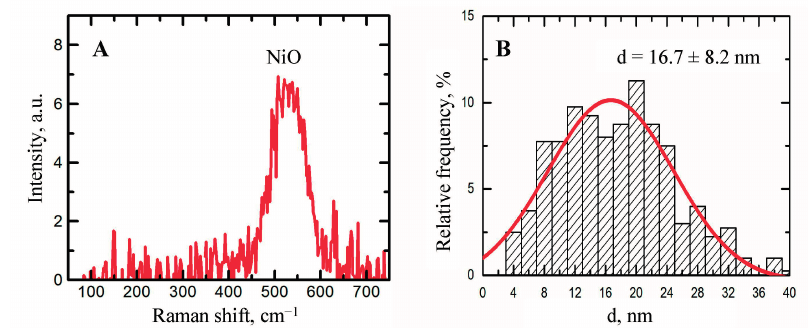
Figure 9. Characteristics of nickel oxide NPs produced by laser ablation. ( A ) Raman spectrum; ( B ) size distribution function obtained by statistical processing of SEM NPs